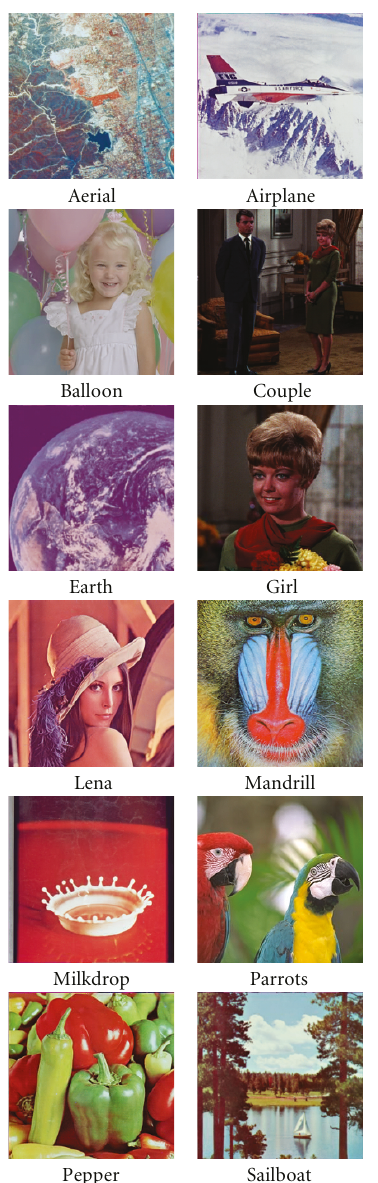
Figure 13: Watermarked images (JPEG50, maxQ).